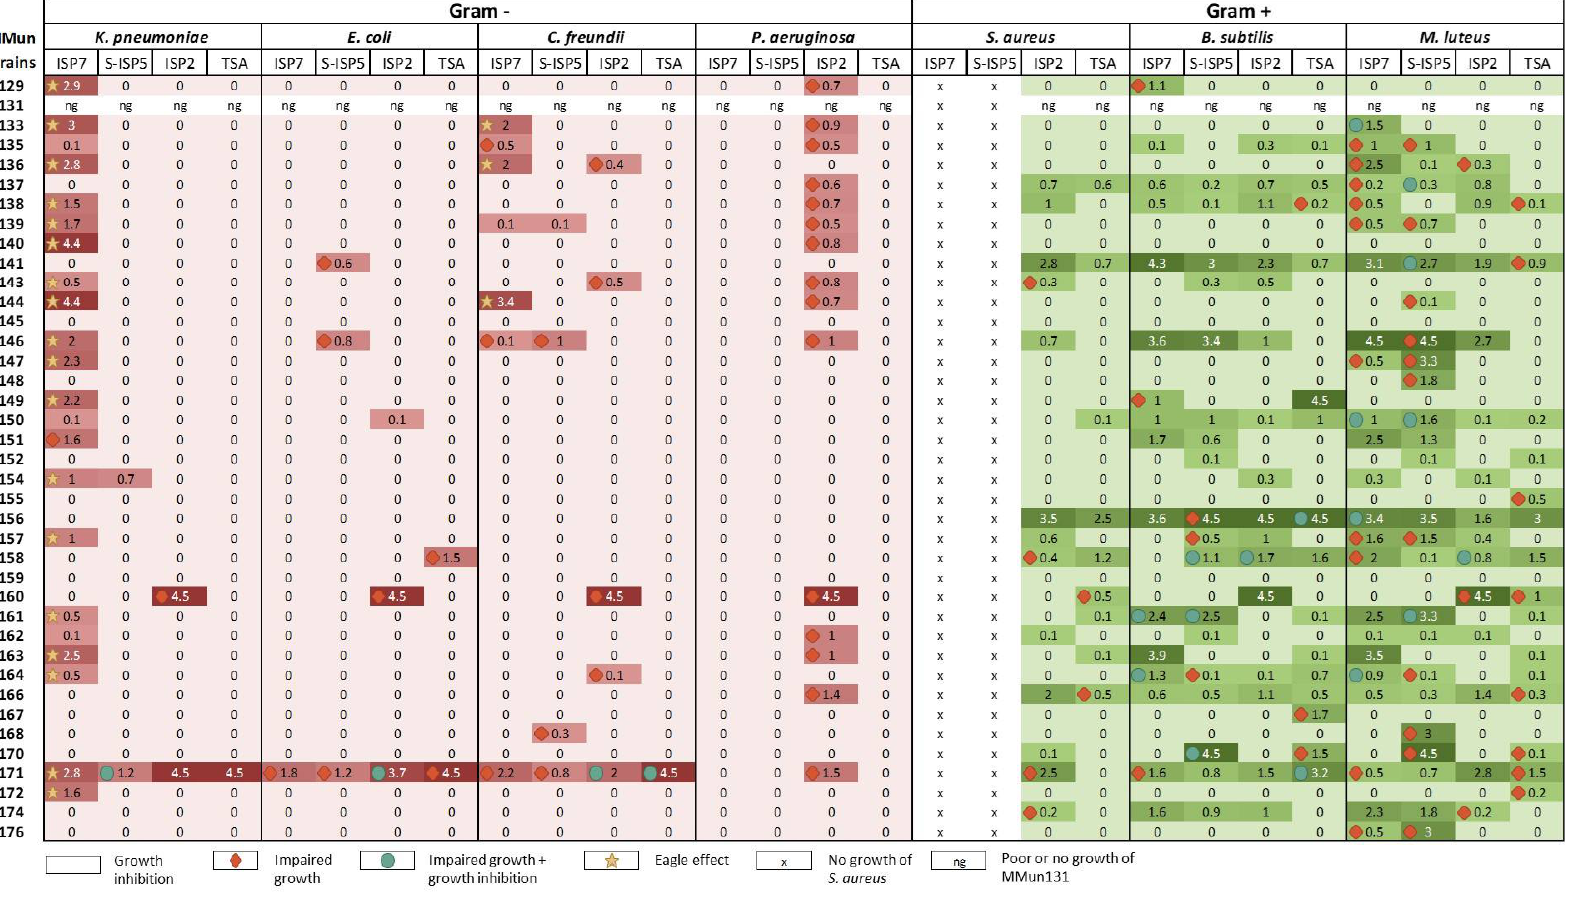
Figure 6. Heatmap illustrating antibacterial activities of the moonmilk actinobacteria isolated in this study. The size of the inhibition zone (in cm) is given for each strain.